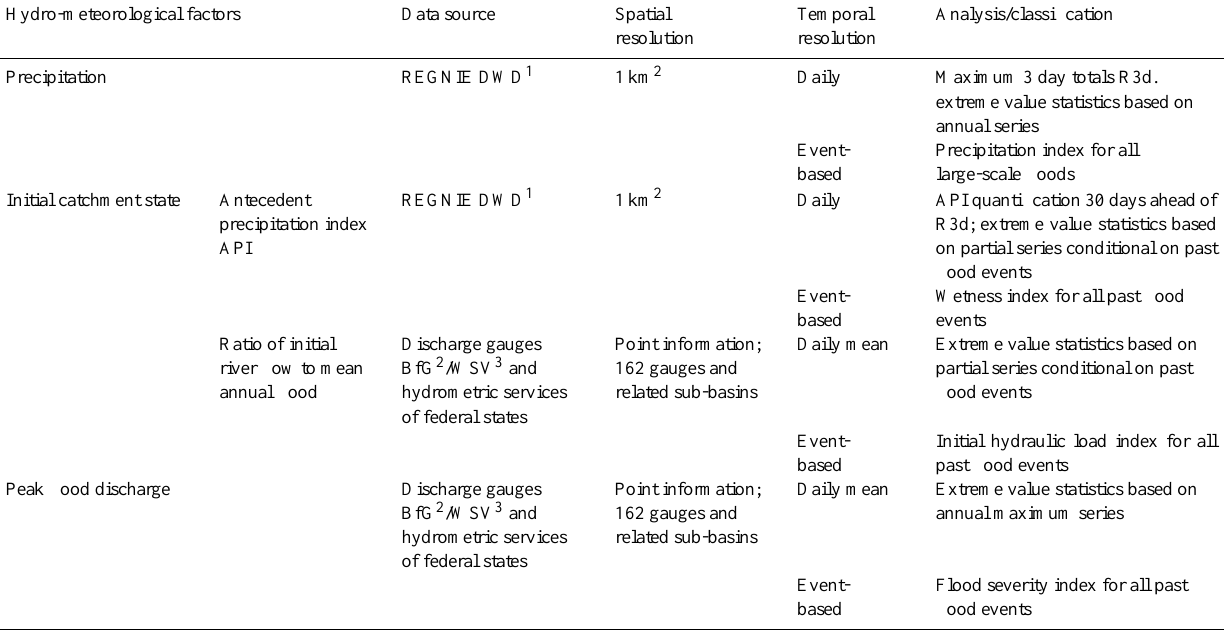
Table 1. Data sources, resolution and analysis methods for hydro-meteorological